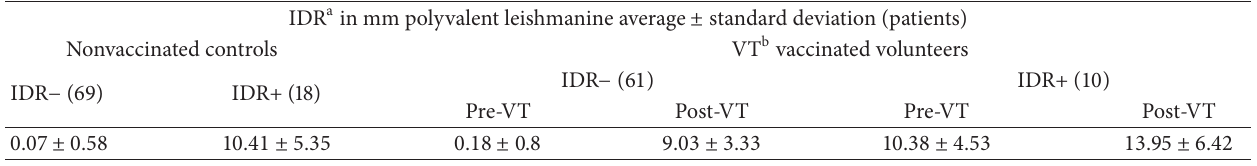
Table 5: Delayed type hypersensitivity in intradermic reaction positive and negative volunteers in VT vaccinated and controls. IDR a in mm polyvalent leishmanine average ± standard deviation (patients) Nonvaccinated controls